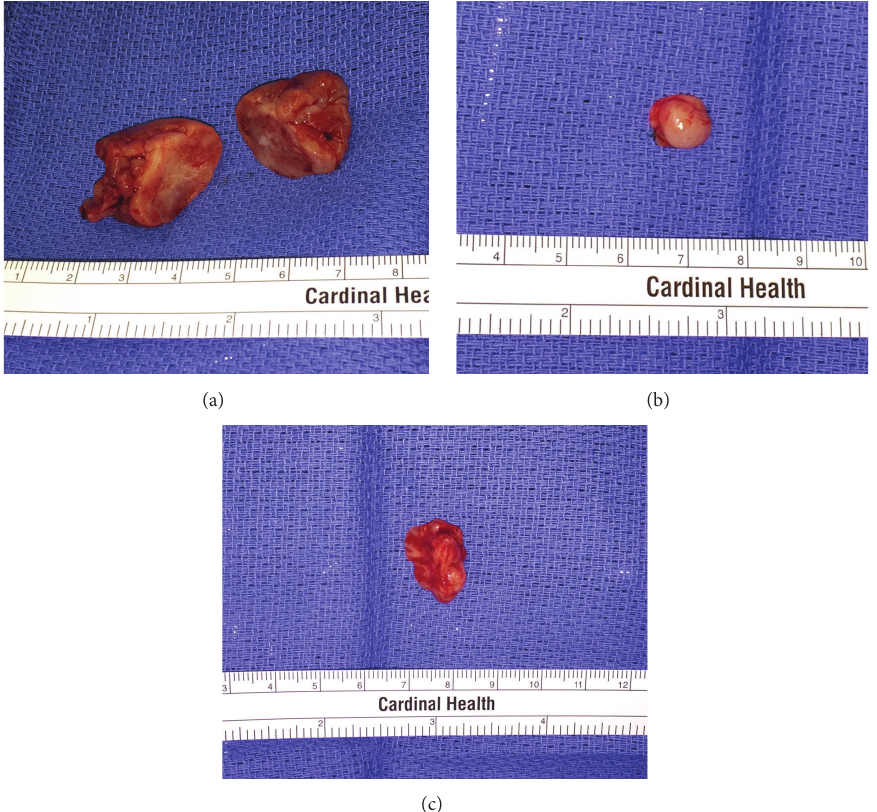
Figure 3: Left posterior buccal (a), anterior buccal (b), and palatal (c) maxillary sublesions. The left posterior buccal sublesion was sectioned for gross examination.